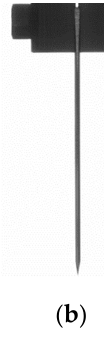
Figure 1. ( a ) Cutting blade measurement system; ( b ) cutting